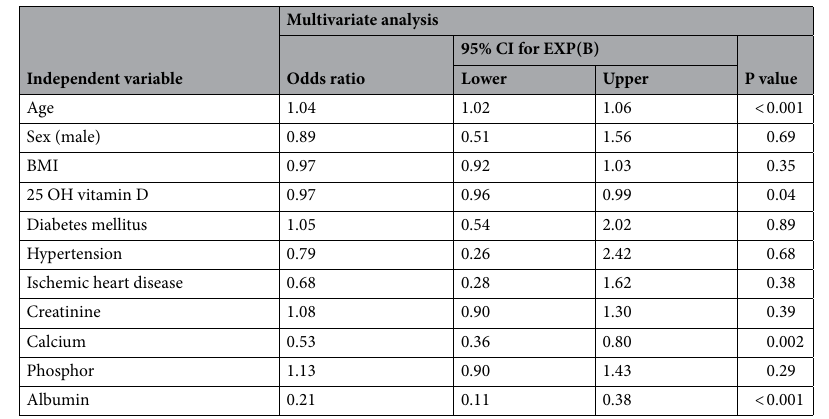
Table 4. Multivariate odds ratio and 95% confidence for association between the serum level of 25 hydroxyvitamin D and COVID-19 disease mortality. COVID‑19 coronavirus 2019 disease, CI confidence interval, BMI body mass index. Mortality vs. recovery. After adjustment for sex, BMI, past history of diabetes mellitus, hypertension, ischemic heart disease, creatinine, phosphor, albumin. Odds ratio change in mortality per standard deviation increase in scale independent variable. Each odds ratio result is adjusted for each of the other independent variables in the